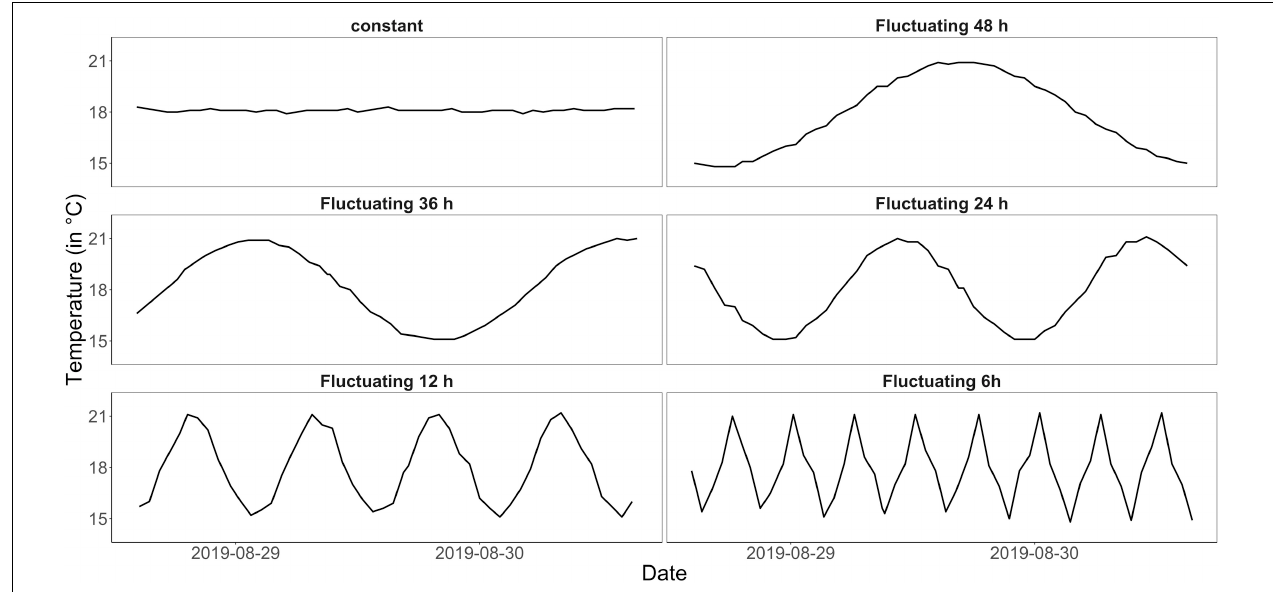
FIGURE 1 | Measured temperature curves for the different treatments (constant control and fluctuation every 6, 12, 24, 36, and 48 h) within 50 h (data shown here for one replicate mesocosm each, from August 28 to August 30; see Supplementary Figure 1 for a complete temperature time series for each mesocosm). All treatments had the same mean temperature of 18 ◦ C and temperature fluctuations had the same amplitude of 3 ◦ C, thus were applied over the range of 15–21 ◦